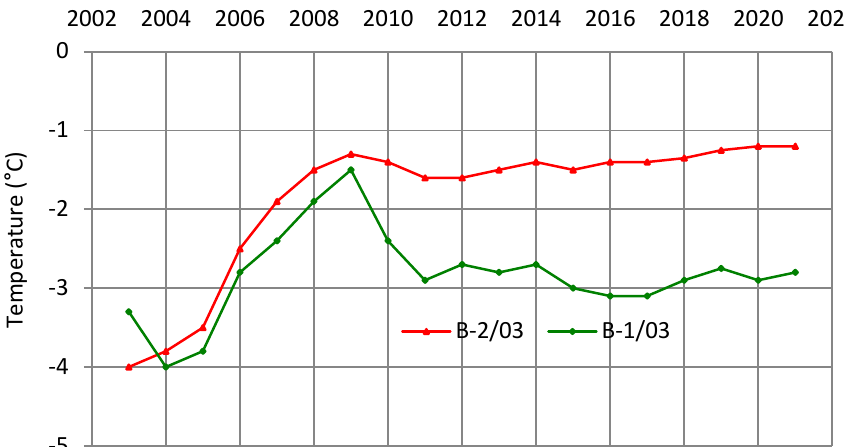
Figure 9. Variation in the mean annual ground temperature at 10 m depth in the birch–larch stand (B-1/03) and the burned/cleared site (B-2/03) in the inter-alas terrain type along the Mastakh–Yakutsk gas pipeline. Post-fire succession stages: grass (2003–2008), birch–shrub (2009–2014), and birch–larch (after 2015).